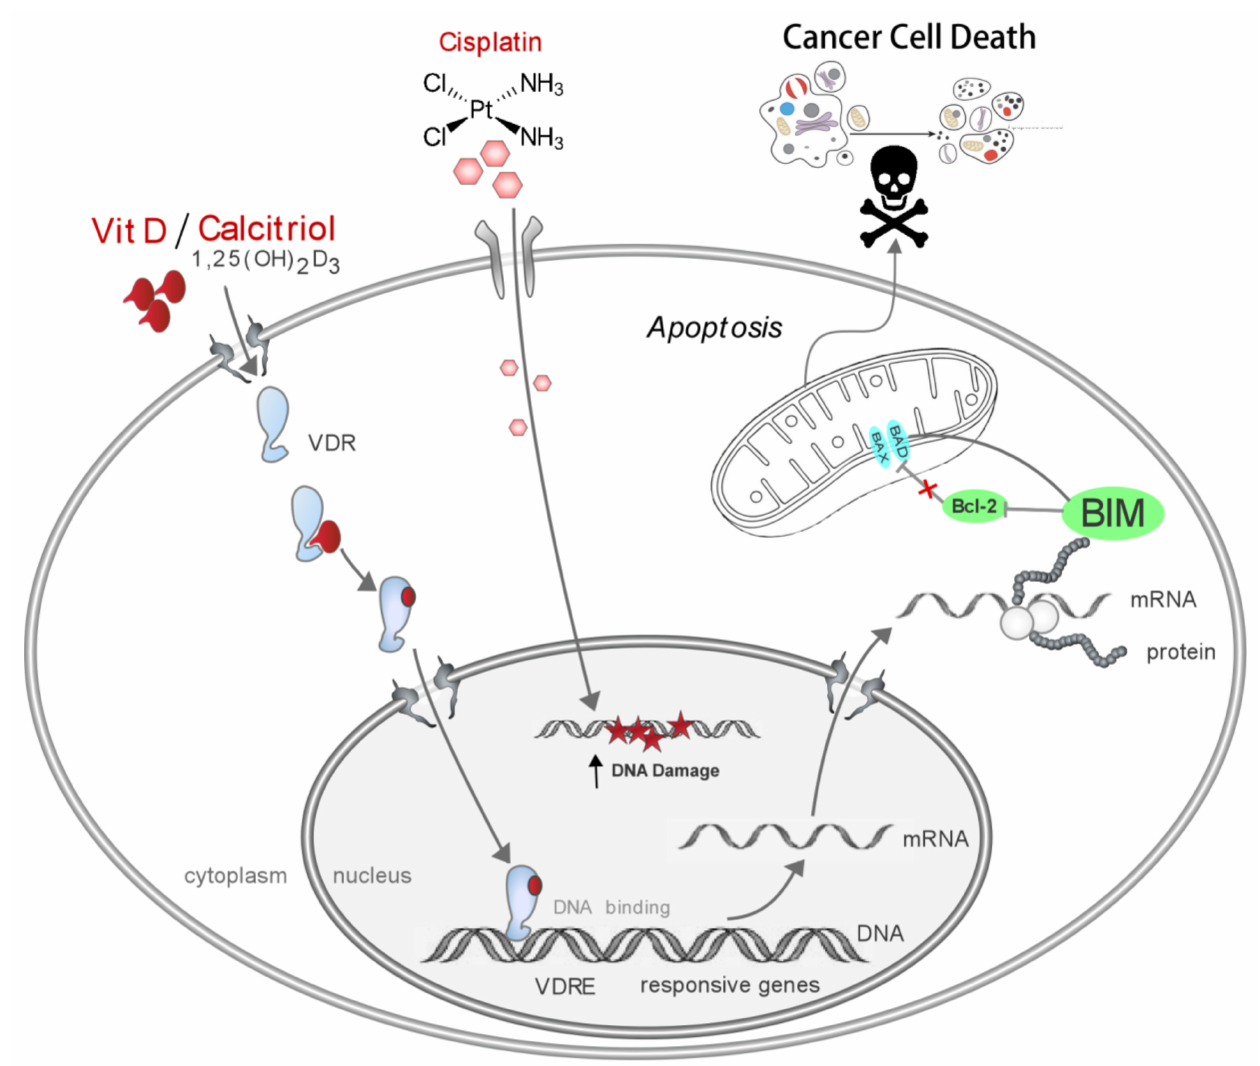
Figure 6. Model summarizing how the VitD/VDR/BIM axis overcomes cisplatin resistance in head and neck cancer. VitD treatment is able to sensitize HNSCC cells to cisplatin-induced cell death via induction of DNA damage and activation of pro-apoptotic pathways. After cellular uptake, VitD binds to VDR, which then translocates to the nucleus and binds to specific promoter sites, thereby inducing multiple pathobiological pathways. In HNSCC, the VitD/VDR complex also induces the expression of the pro-apoptotic protein BIM. BIM efficiently induces the activation of mitochondria- dependent apoptosis, and together with cisplatin-induced DNA-damage, efficiently triggers cancer cell death, including that of cisplatin-resistant cancer cells. Simplified schematic illustration of pathways and players, not drawn to